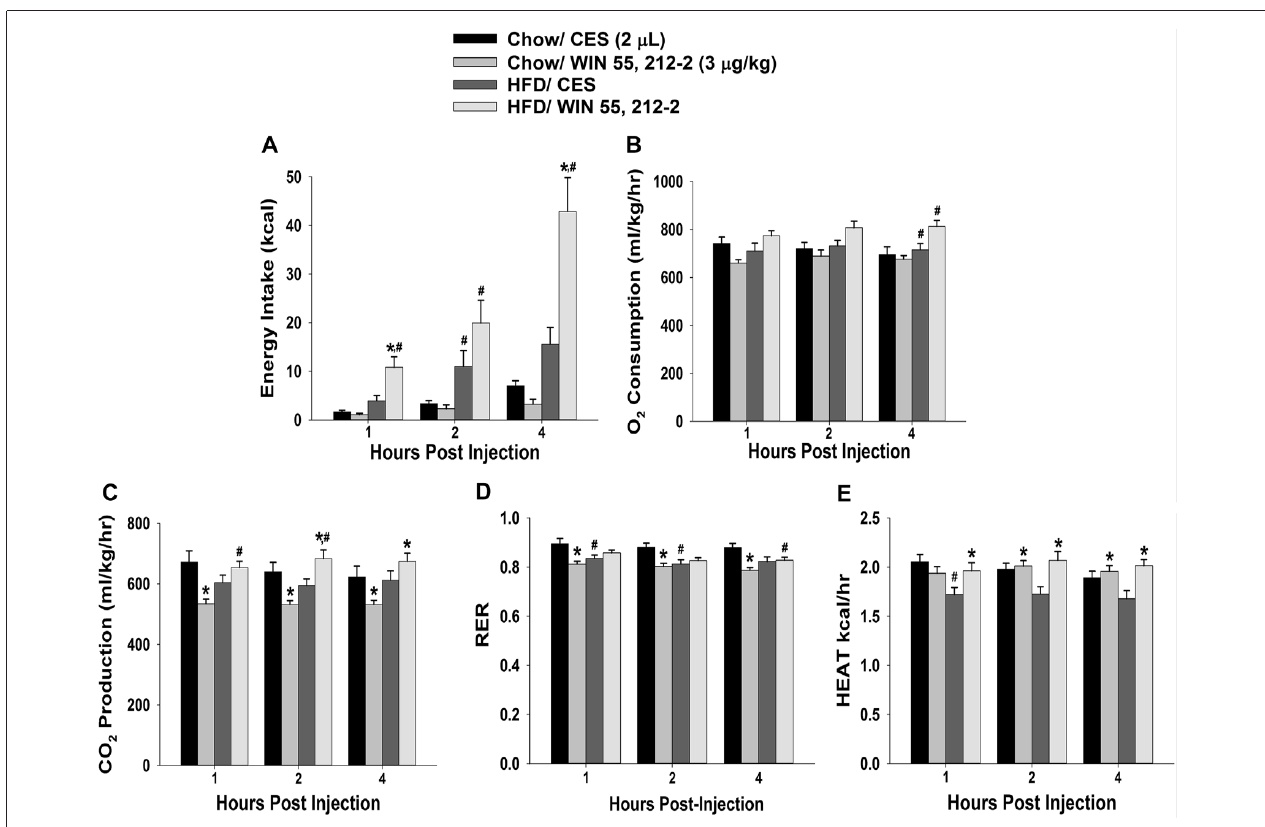
FIGURE 2 | Activation of hypothalamic cannabinoid receptors increases energy intake and various measures of energy expenditure in HFD- but not chow-fed periovulatory female guinea pigs. Bars represent means and vertical lines 1 SEM of the cumulative energy intake (A) , O 2 consumption (B) , CO 2 production (C) , respiratory exchange ratio (RER; D) and metabolic heat production (E) , which were measured 1, 2 and 4 h after administration of WIN 55,212-2 (3 µ g; I.3.V) or its CES vehicle (2 µ L; I.3.V). ∗ P < 0.05 relative to CES treated animals; multifactorial ANOVA/LSD; n = 5. # P < 0.05 relative to chow-fed animals; repeated measures, multifactorial ANOVA/LSD; n =